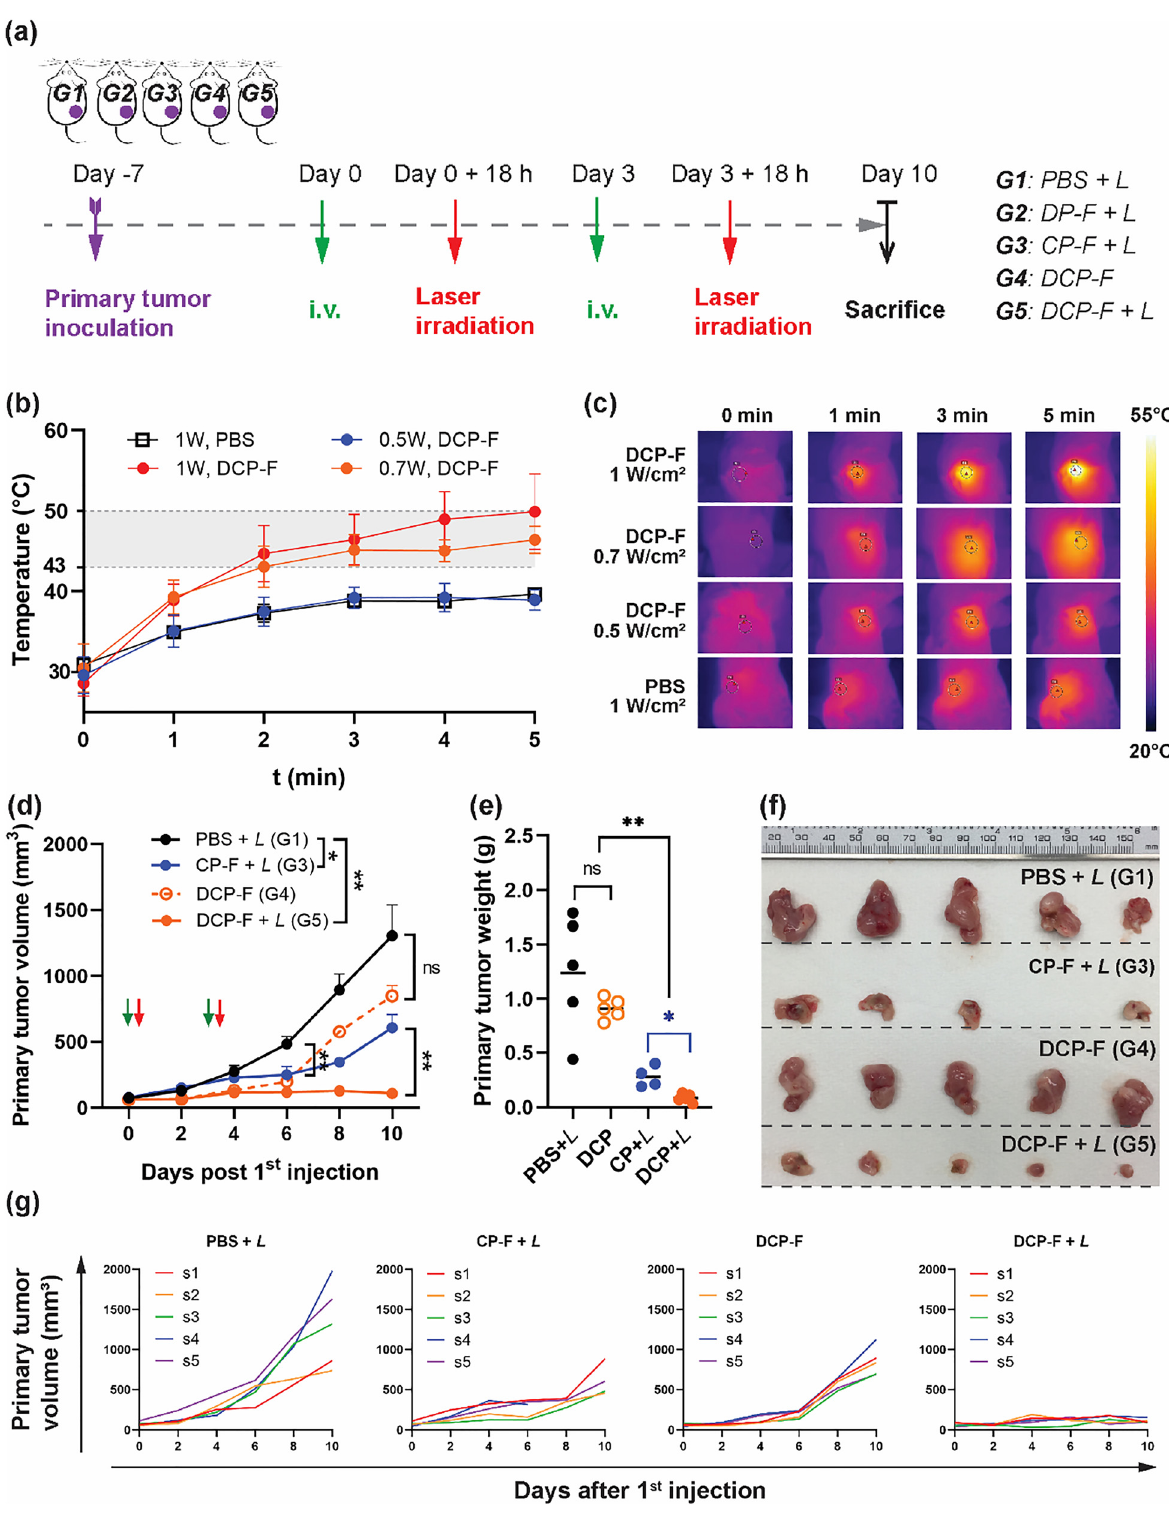
Figure 4: Primary tumor inhibition of different treatments. (a) Tumor inoculation and treatment schedule; (b) in vivo tumor temperature and (c) representative thermal images; (d) tumor growth pro fi le and(e)tumorweightat day10 after1 st injection;(f) tumorphotographs of eachtreatmentgroupat day10; and(g)tumor growthpro fi leof each mouseineachgroup.L:denotedasNIRlasertreatment,i.e.808nmlaserirradiationfor5min.NotethatonemouseinCP-F + L(G3)wasculled due to accident leg injury. Intense adaptive immune responses promoted via DCP-F + L